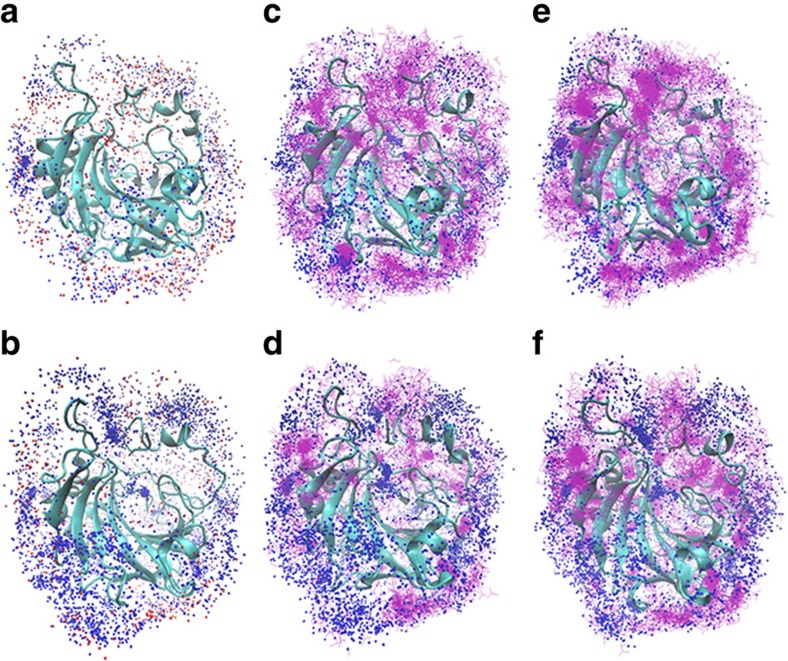
Overlays showing the distribution of cations and anions within 3 Å of the enzyme surface.The overlays incorporate anions and cations from 500 frames spanning the 500 ns MD production trajectories. (a,b) NaCl with WT and M4, respectively; (c,d) NaNO3 with WT and M4, respectively; and (e,f) NaHSO4 with WT and M4, respectively. Na+ cations are depicted as dark blue spheres, HSO4− and NO3− anions are depicted as purple lines and Cl− anions are depicted as orange spheres.